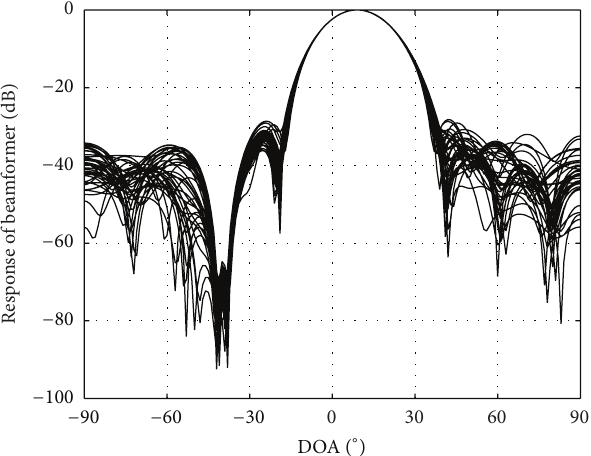
Figure 5: Response of beamformer with proposed method